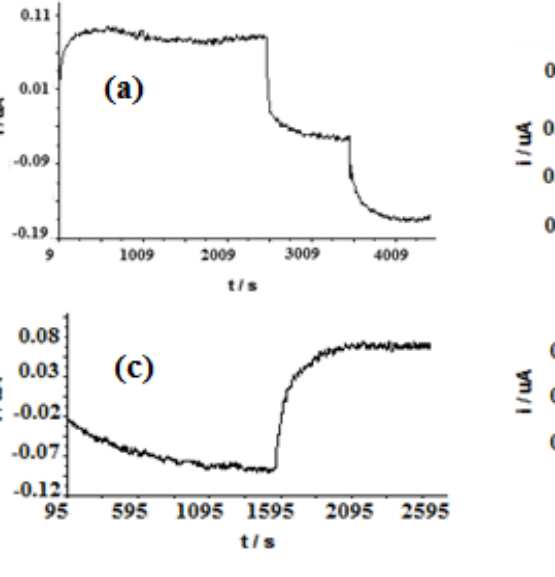
Figure 4. The current response of a biosensor: At 50 µM and 100 µM H capsaicin ( b ); 196.1 µM capsaicin in the presence of 50 µM H without HRP enzyme in 196.1 µM capsaicin and 50 µM H in phosphate buffer pH 7/0.1 M